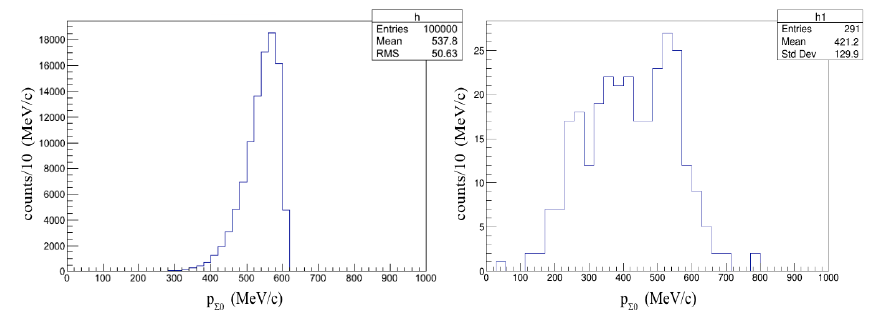
Figure 3. The figure shows comparison among the calculated Σ 0 momentum spectrum (left) for the process in Eq. (1) and the measured distribution (right) for the Σ 0 d events reconstructed by using partial statistics from the 2012 data taking